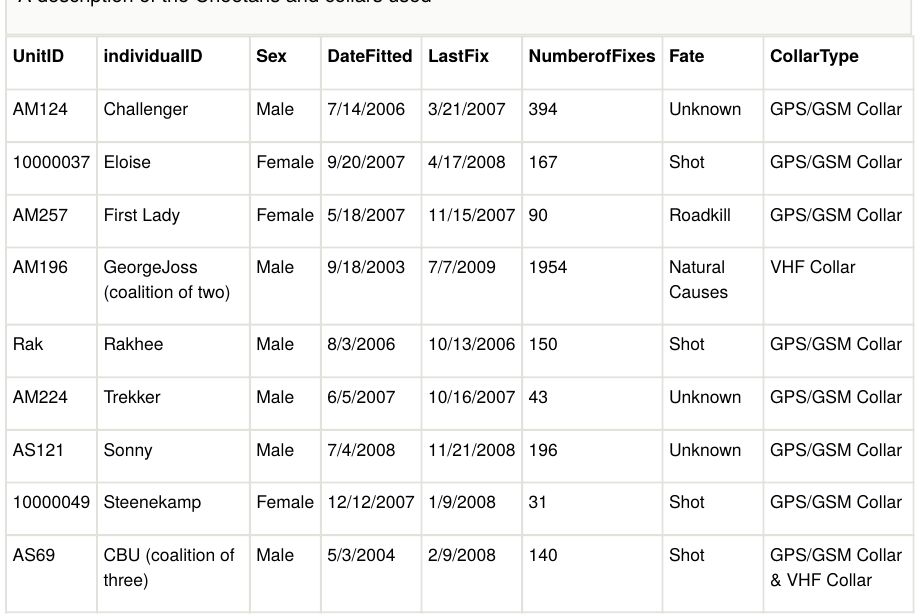
A description of the Cheetahs and collars